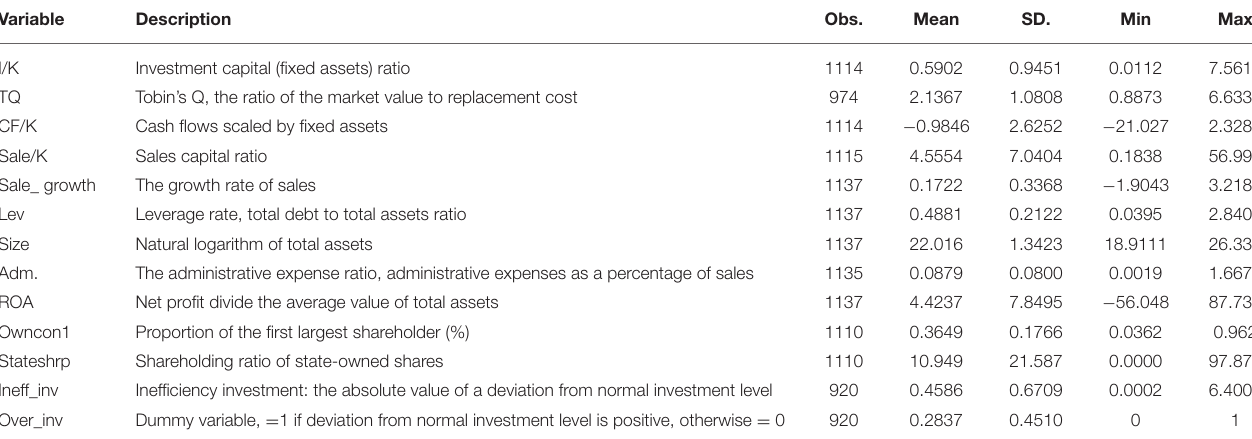
TABLE 1 | Descriptive statistics on the main variables.